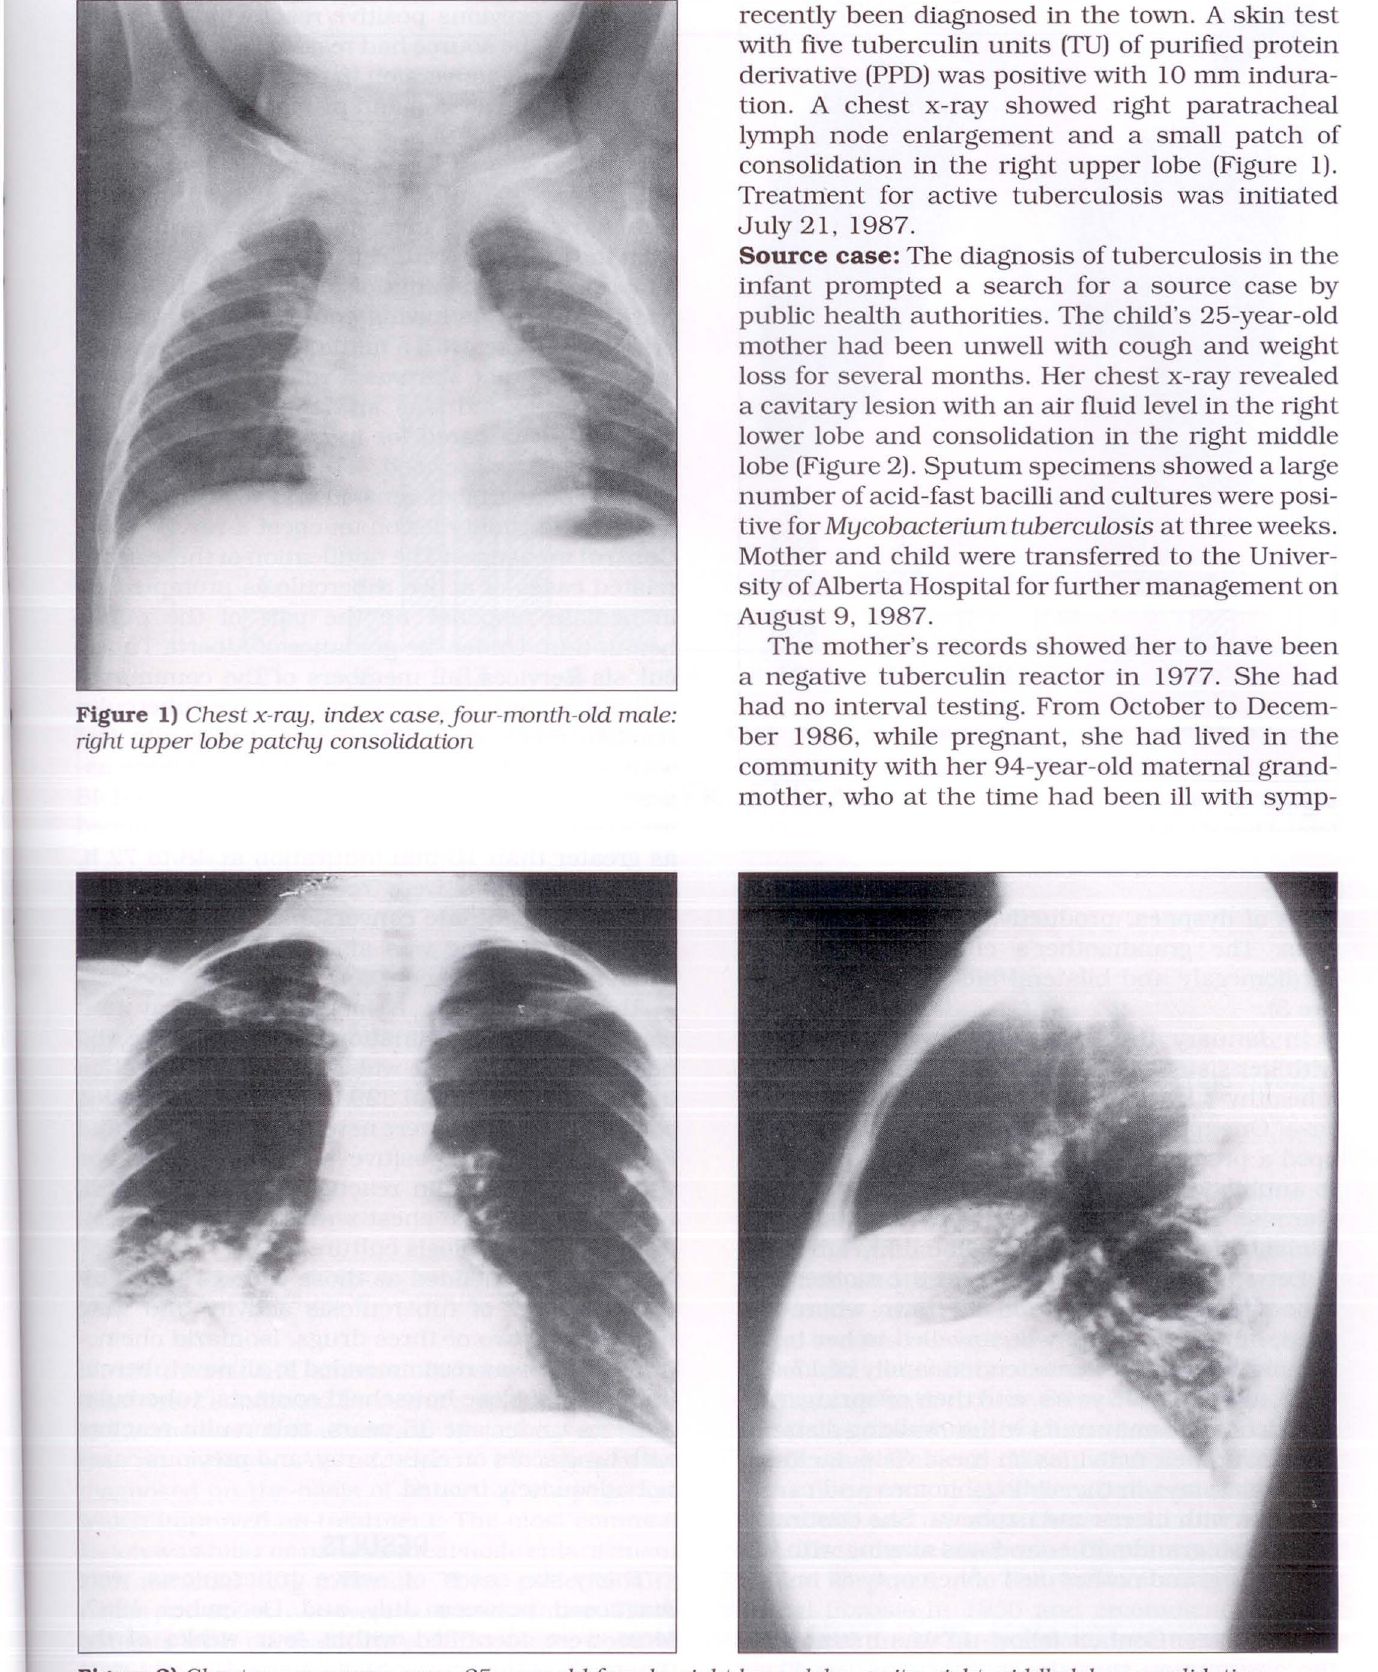
Figure 2) Chest x-ray, source case, 25-year-oldjemale: right lower lobe cavity, right middle lobe consolidation